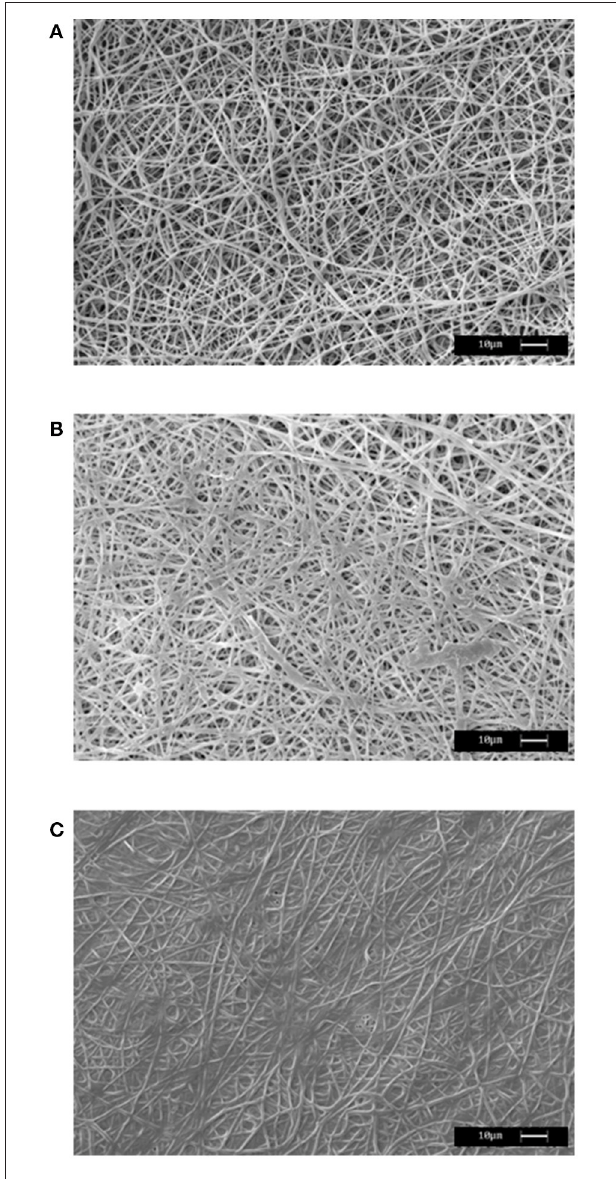
FIGURE 2 | Representative SEM images of PLLA mat (A) , mHELP deposited on the PLLA matrix in the absence of cross-linking (B) and mHELP undergone cross-linking after deposition on PLLA matrix (C) . Bar is 10 µ